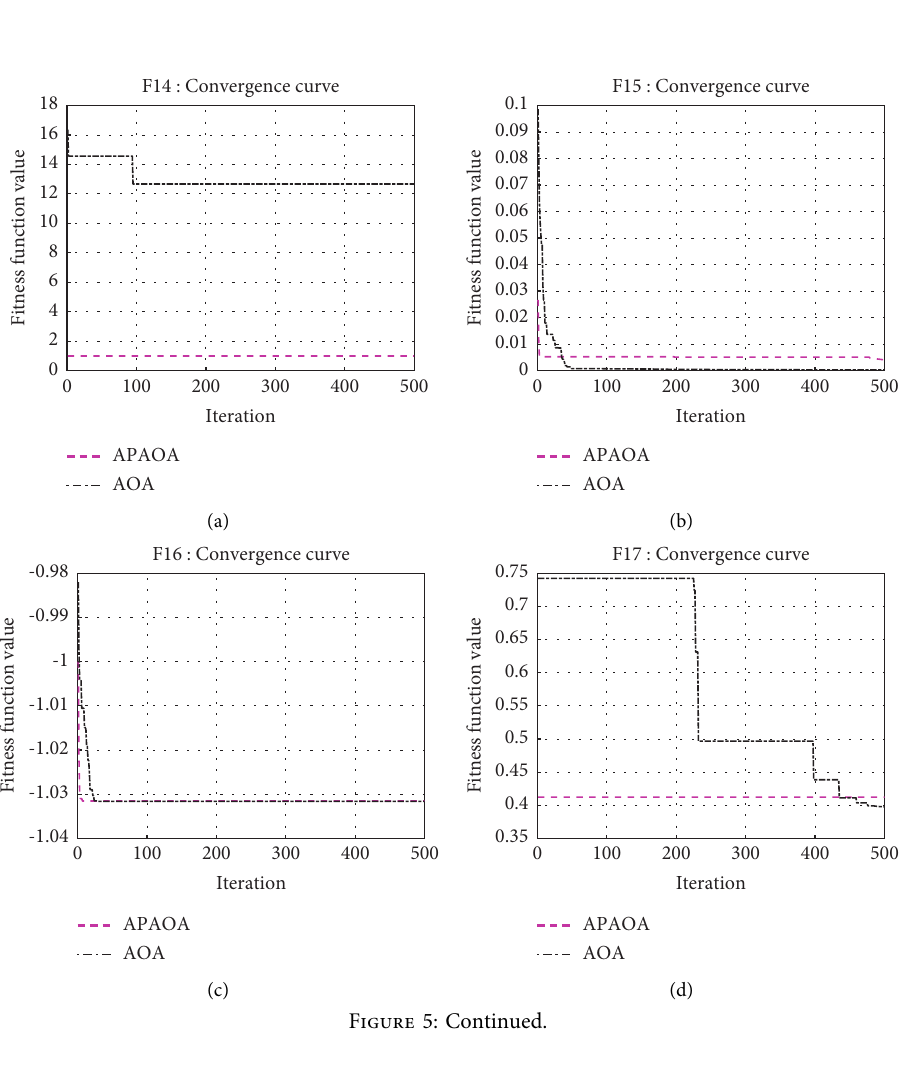
F16 : Convergence curve F17 : Convergence